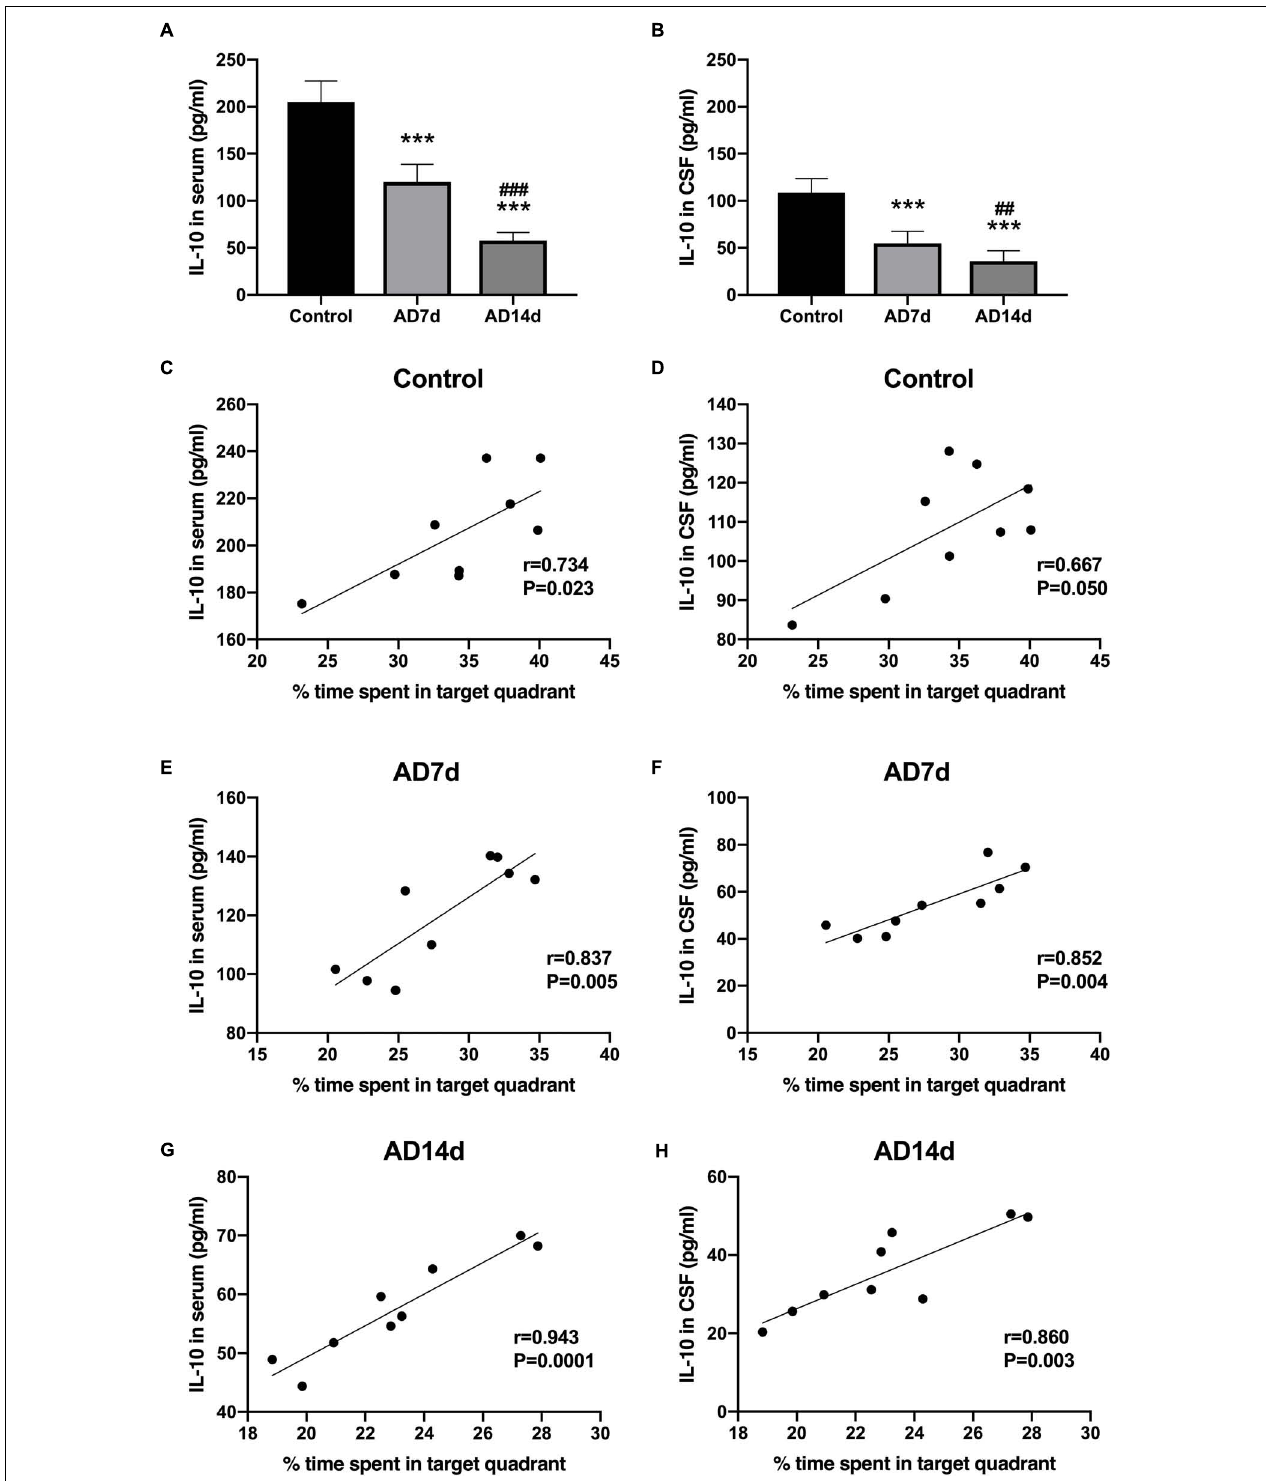
FIGURE 5 | Decreased IL-10 concentrations in the serum and CSF of AD rats. IL-10 concentrations in the serum (A) and CSF (B) of the Control, AD7d and AD14d groups were determined with use of ELISA. n = 9 per group, mean ± standard deviation, ∗∗∗ P < 0.001 vs. Control group, ## P < 0.01, ### P < 0.001 vs. AD7d group. Positive correlations were obtained between serum IL-10 concentrations and percent of time in the target quadrant in the Control (C) , AD7d (E) , and AD14d (G) groups. Positive correlations were obtained between CSF IL-10 concentrations and percent of time in the target quadrant in the Control (D) , AD7d (F) , and AD14d (H)